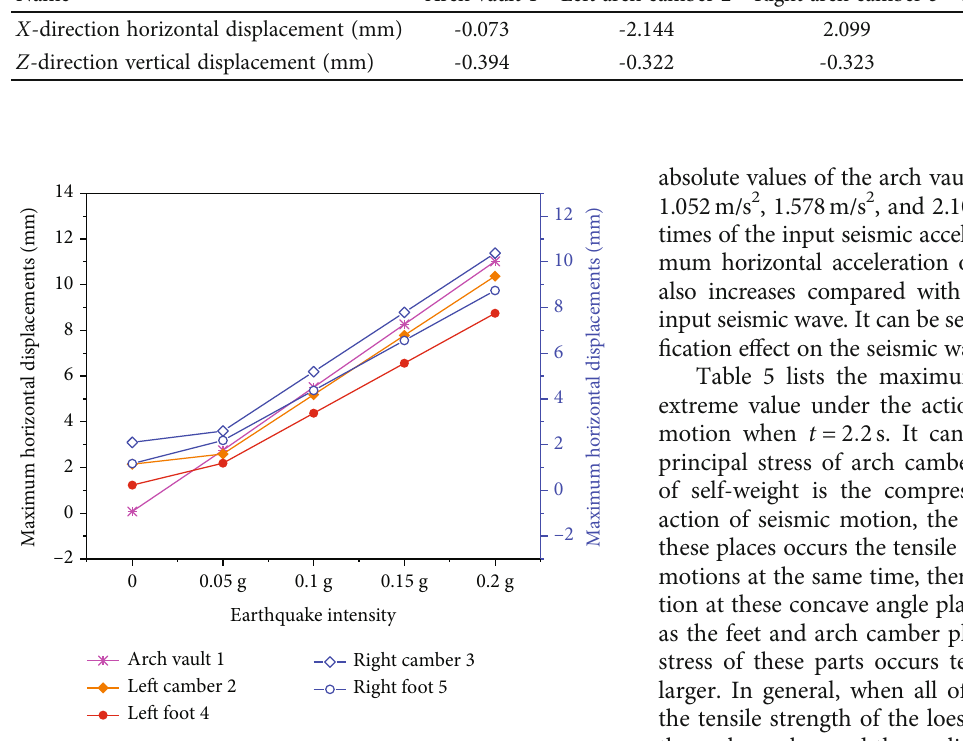
Figure 9: Maximum horizontal displacement of key points under four seismic waves.